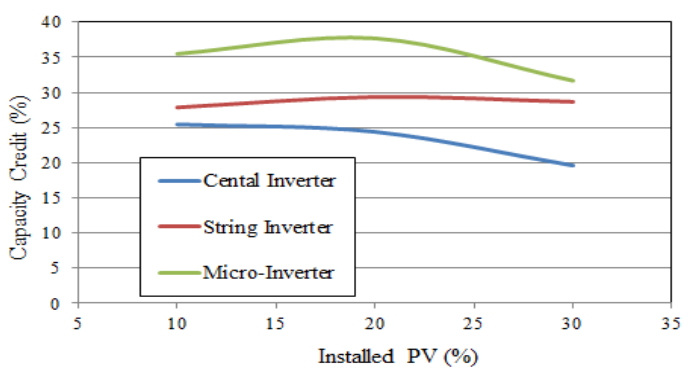
Figure 16. Capacity credit for three different topologies.